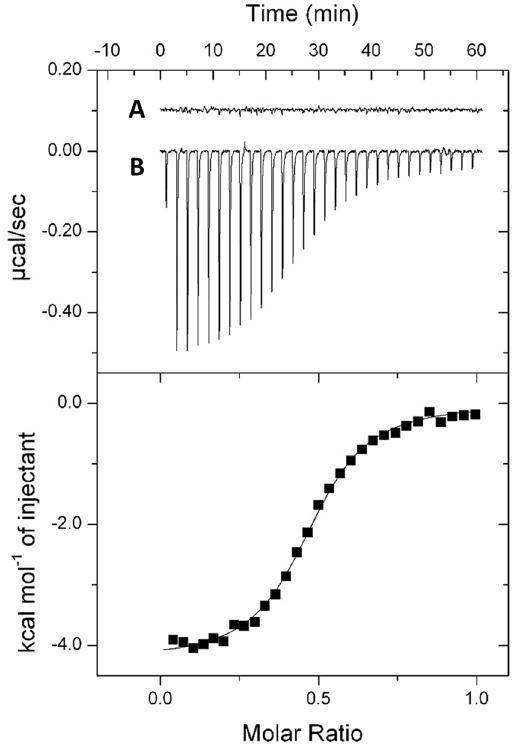
Figure 4. Isothermal titration calorimetry (ITC). A, Titration of ITC buffer with 1 mM boric acid; B, Titration of 200 μ M McpB LBD with 1 mM boric acid. Upper panel shows the raw titration data, and lower panel shows the integrated, dilution-corrected and concentration-normalized peak areas of the raw titration data. The data were fitted using the One Set of Sites model of the MicroCal version of